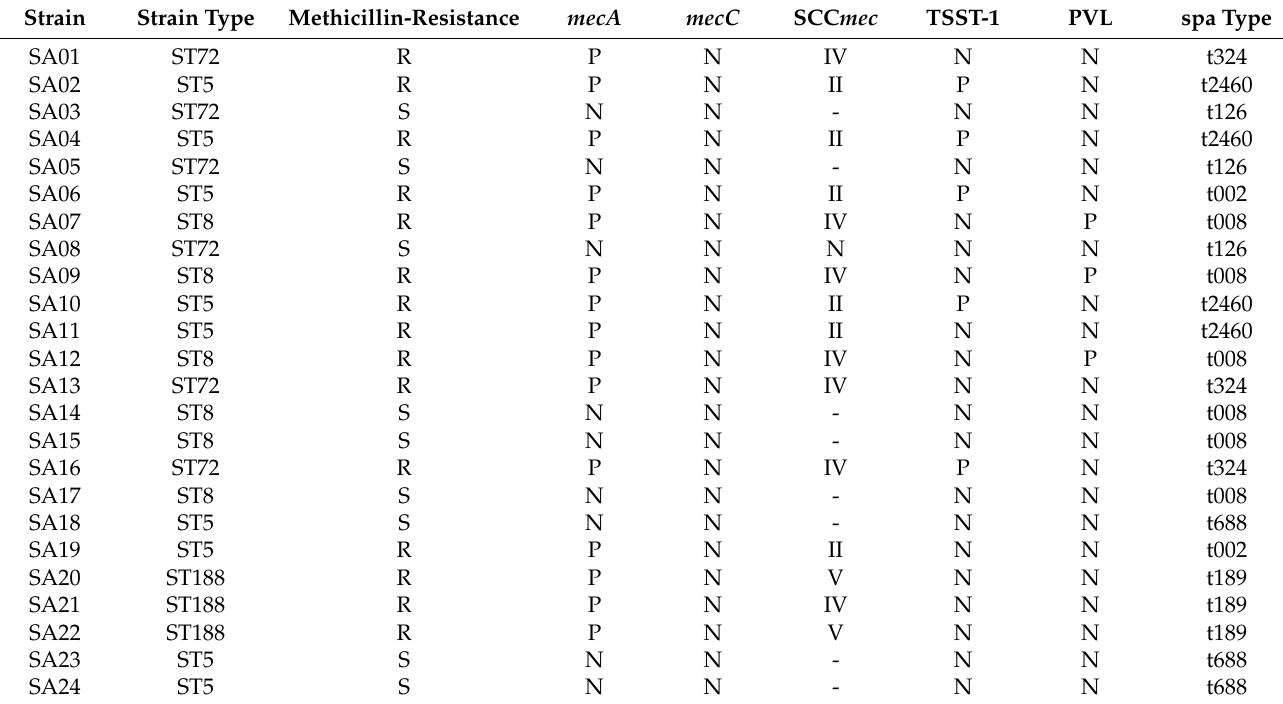
Table 1. Molecular data for the isolates tested in this